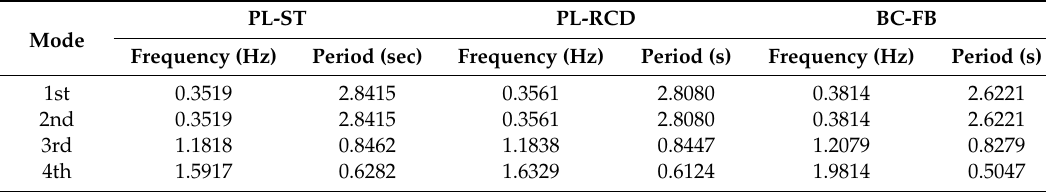
Table 9. Results of natural frequency